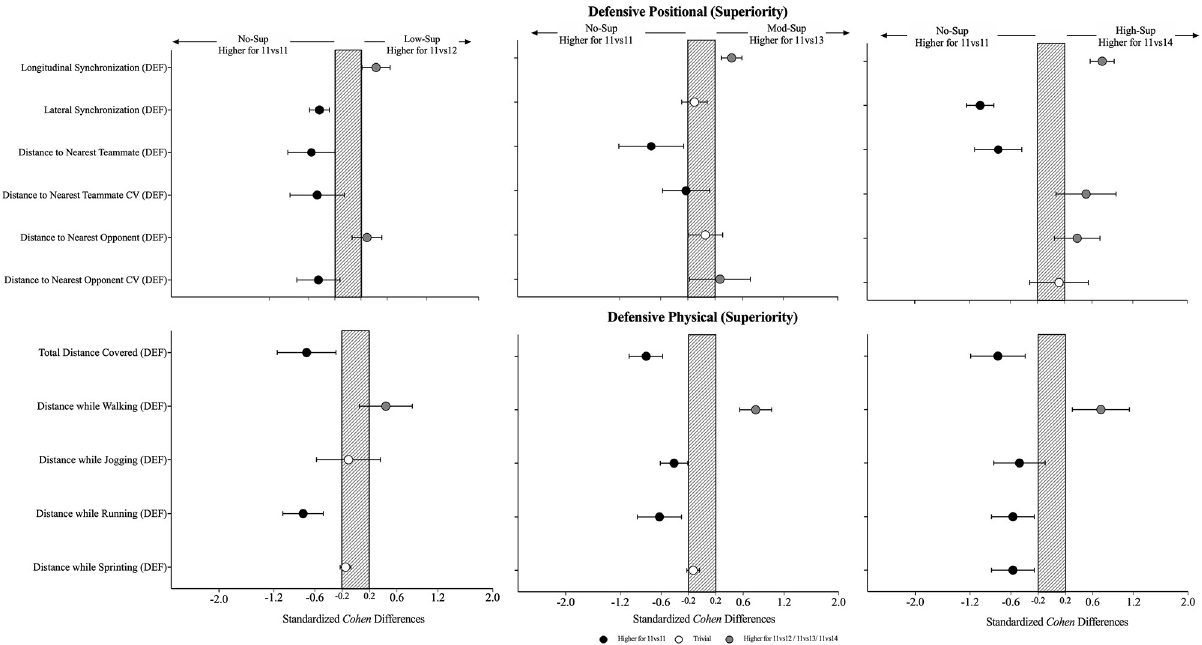
Fig 3. Standardised (Cohen) differences in physical and collective tactical variables considering the increase in the number of teammates (cooperation-perspective) during the defensive phase. Error bars indicate uncertainty in the true mean changes with 90% confidence intervals. OFF = offensive; DEF =